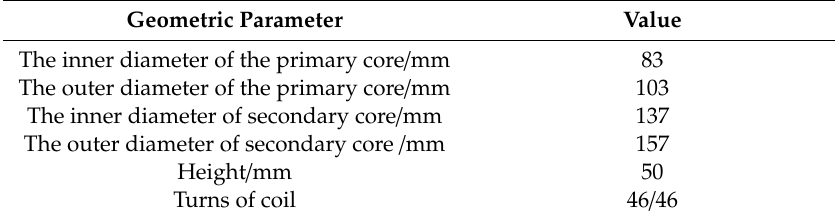
Figure 3. Axial loosely coupled transformer. ( a ) Two-dimensional axisymmetric model;( b ) three-dimensional model. Table 1. Geometric parameters of the axial loosely coupling transformer.